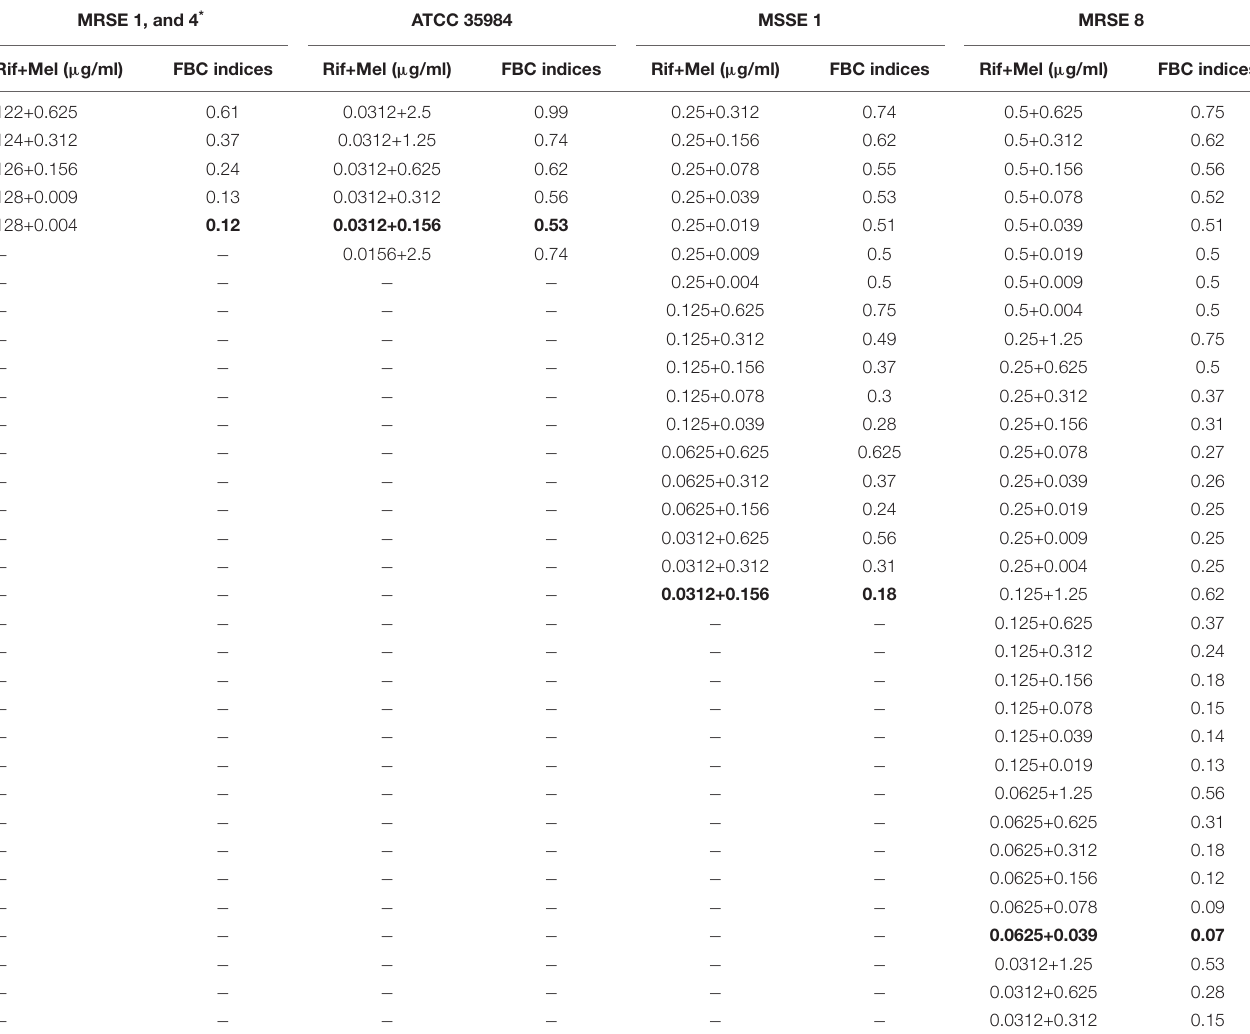
TABLE 5 | The best synergistic concentrations of Rifampin-Melittin based on MBC against selected isolates. MRSE 1, and 4 * Rif+Mel ( µ